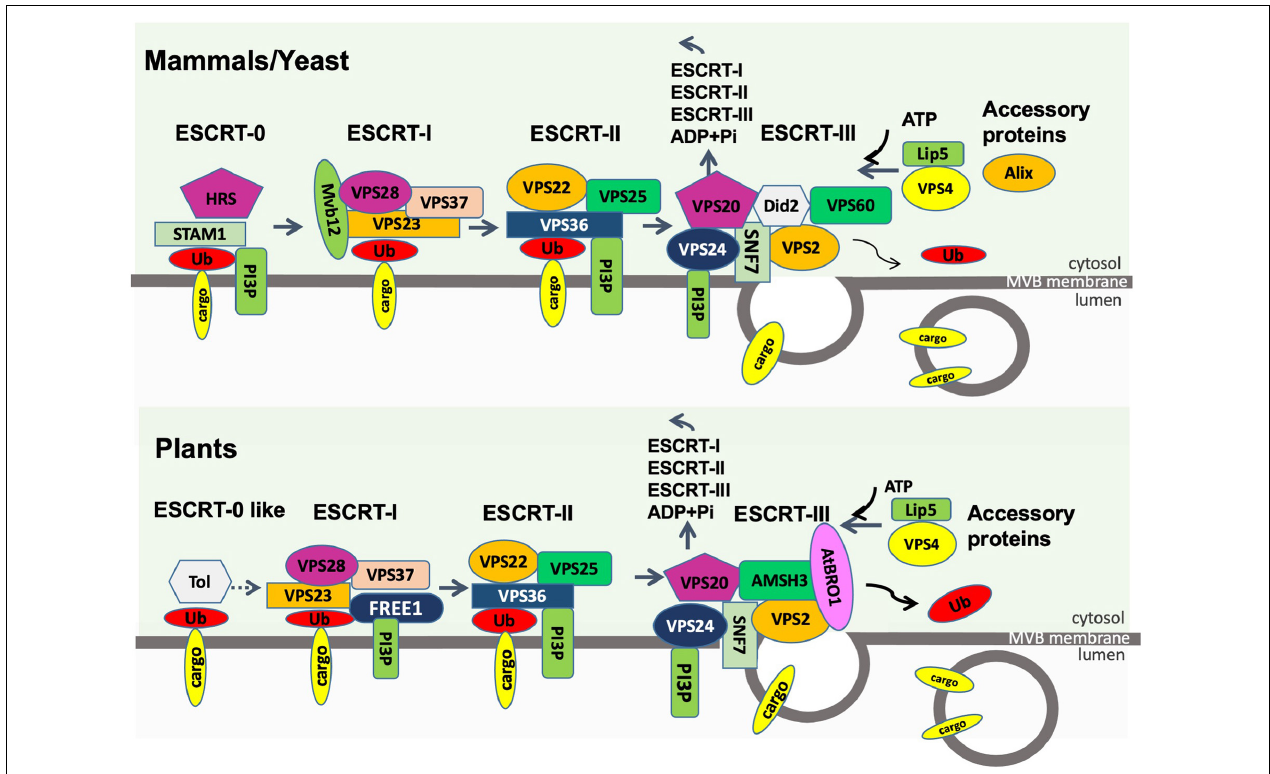
FIGURE 4 | Endosomal sorting complex required for transport (ESCRT) machinery in plants compared to that in mammals and fungi. The process of loading ubiquitinated membrane cargoes into exosomes is shown. Ub, ubiquitin; PI3P, phosphatidylinositol-3-phosphate; ADP, adenosine diphosphate; Pi, phosphate. All other entities shown are protein components of the ESCRT machinery. The first step in the plant pathway is not well